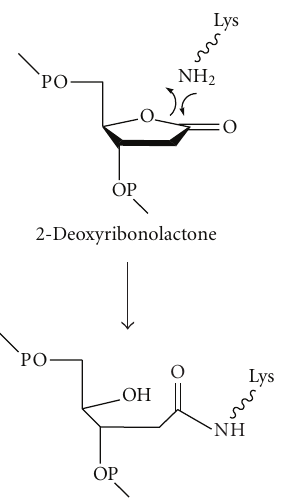
Figure 7: Formation of DNA-protein cross-links during repair of 2-deoxyribonolactone abasic sites in